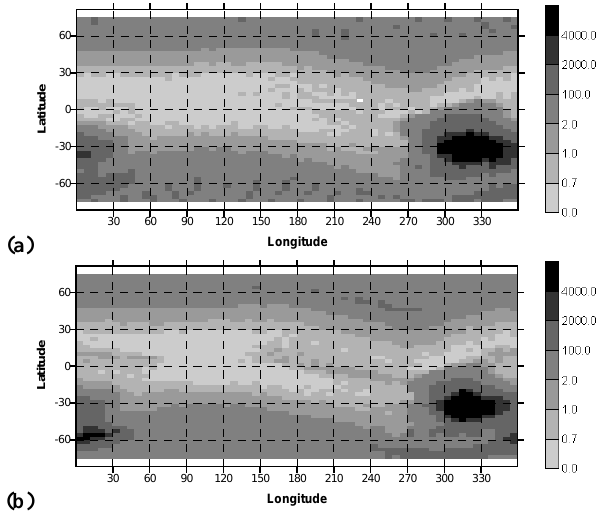
Fig. 7. Geographical distribution of quiet-time fluxes of > 0.6 electrons and > 0.8 protons measured by the SAMPEX/LEICA on July 2000 (a) and October 2003 (b) . The intensities are in- dicated in a gray scale from < 0.7cm − 2 s − 1 sr − 1 (light gray) to > 4000cm − 2 s − 1 sr − 1 (black). Most intense fluxes at middle lati- tudes ( < 40 ◦ ) are observed in the region of South Atlantic